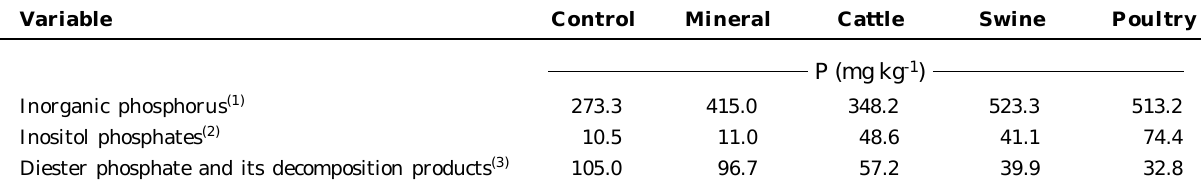
Table 4. Phosphorus groups formed by similar compounds detected by 31 P-NMR in extracts from soil under no tillage after application of mineral fertilizer and different kinds of organic fertilizer for nine